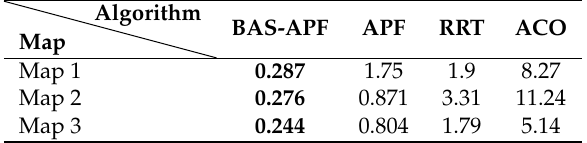
Table 2. Summary of comparison results of various algorithm planning time.